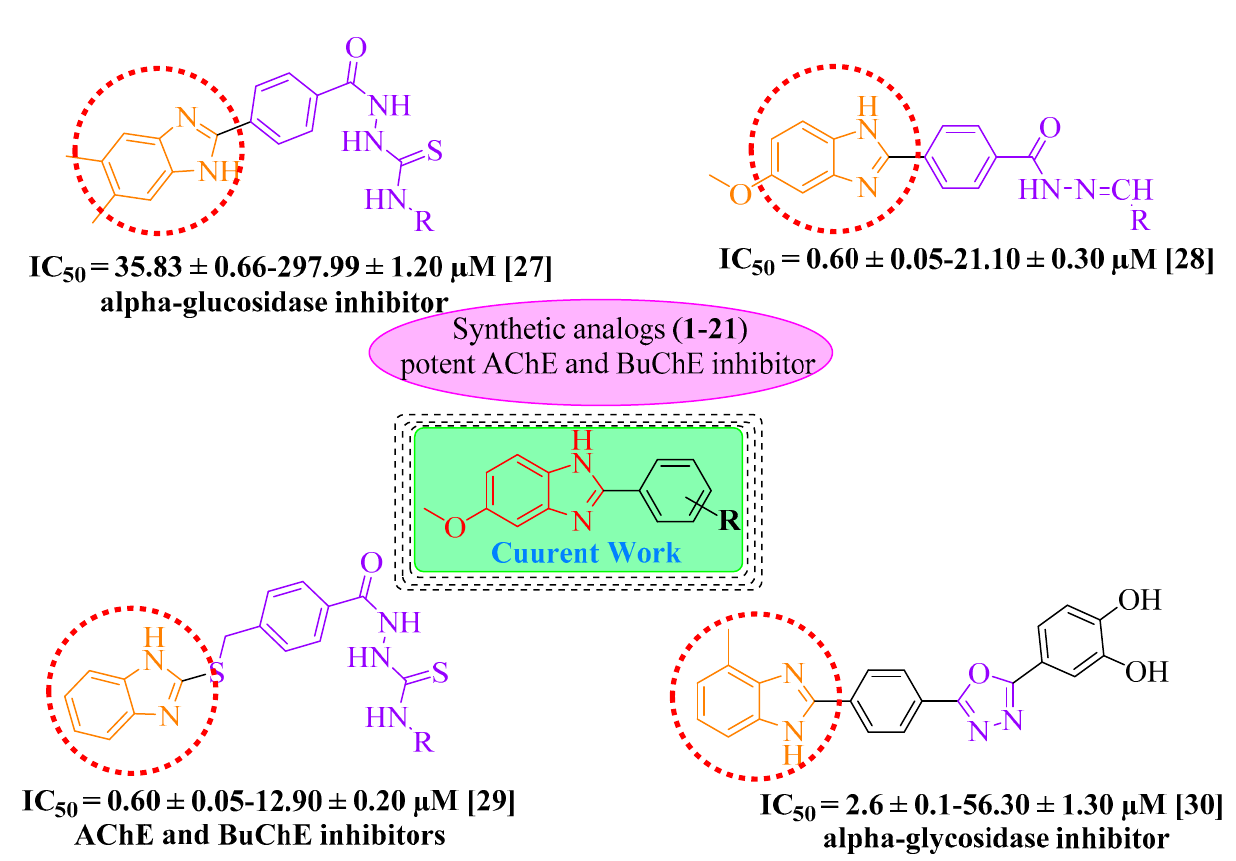
Figure 1. Rationale of the current